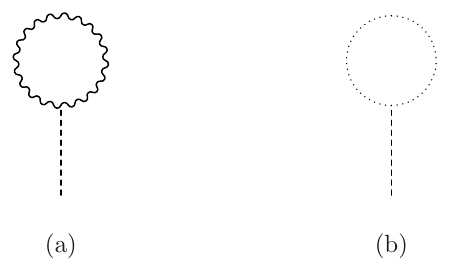
Figure 3. The tadpole diagrams involving the vector bosons and the ghost